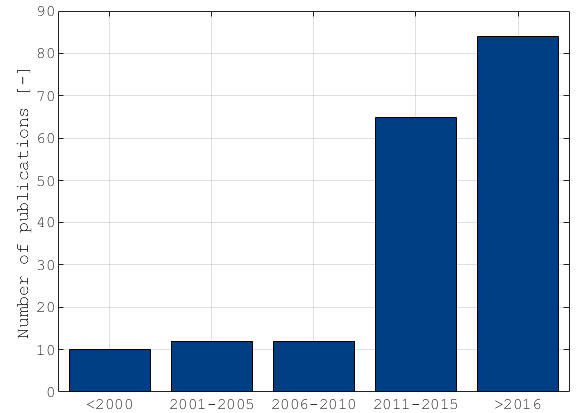
Figure 1. Publications from the literature review [20] based on keywords: vehicle cabin thermal comfort.